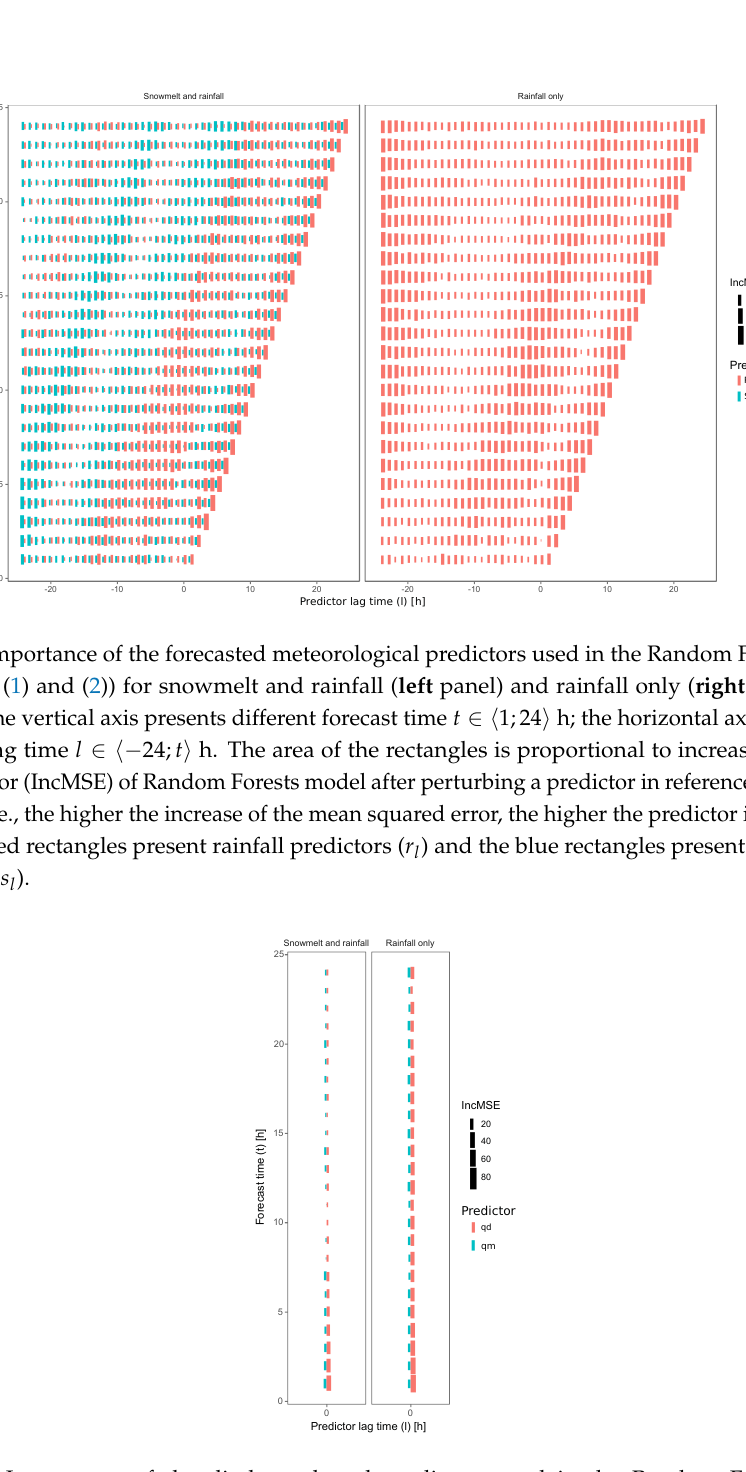
Figure 9. Importance of the discharge-based predictors used in the Random Forests models (Equations (1) and (2)) for the snowmelt and rainfall ( left panel) and rainfall only ( right panel) model variants. The vertical axis presents different forecast time t ∈ (cid:104) 1;24 (cid:105) h; the horizontal axis presents the predictor lag time l ∈ (cid:104)− 24; t (cid:105) h, which is always equal to 0 for this group of predictors. The area of the rectangles is proportional to the increase of the mean squared error (IncMSE) of Random Forests model after perturbing a predictor in reference to an original predictor, i.e., the higher the increase of the mean squared error the higher the predictor importance for a model. Red rectangles present the discharge difference ( qd ) predictor and the blue rectangles the mean discharge ( qm ) predictor (see Section